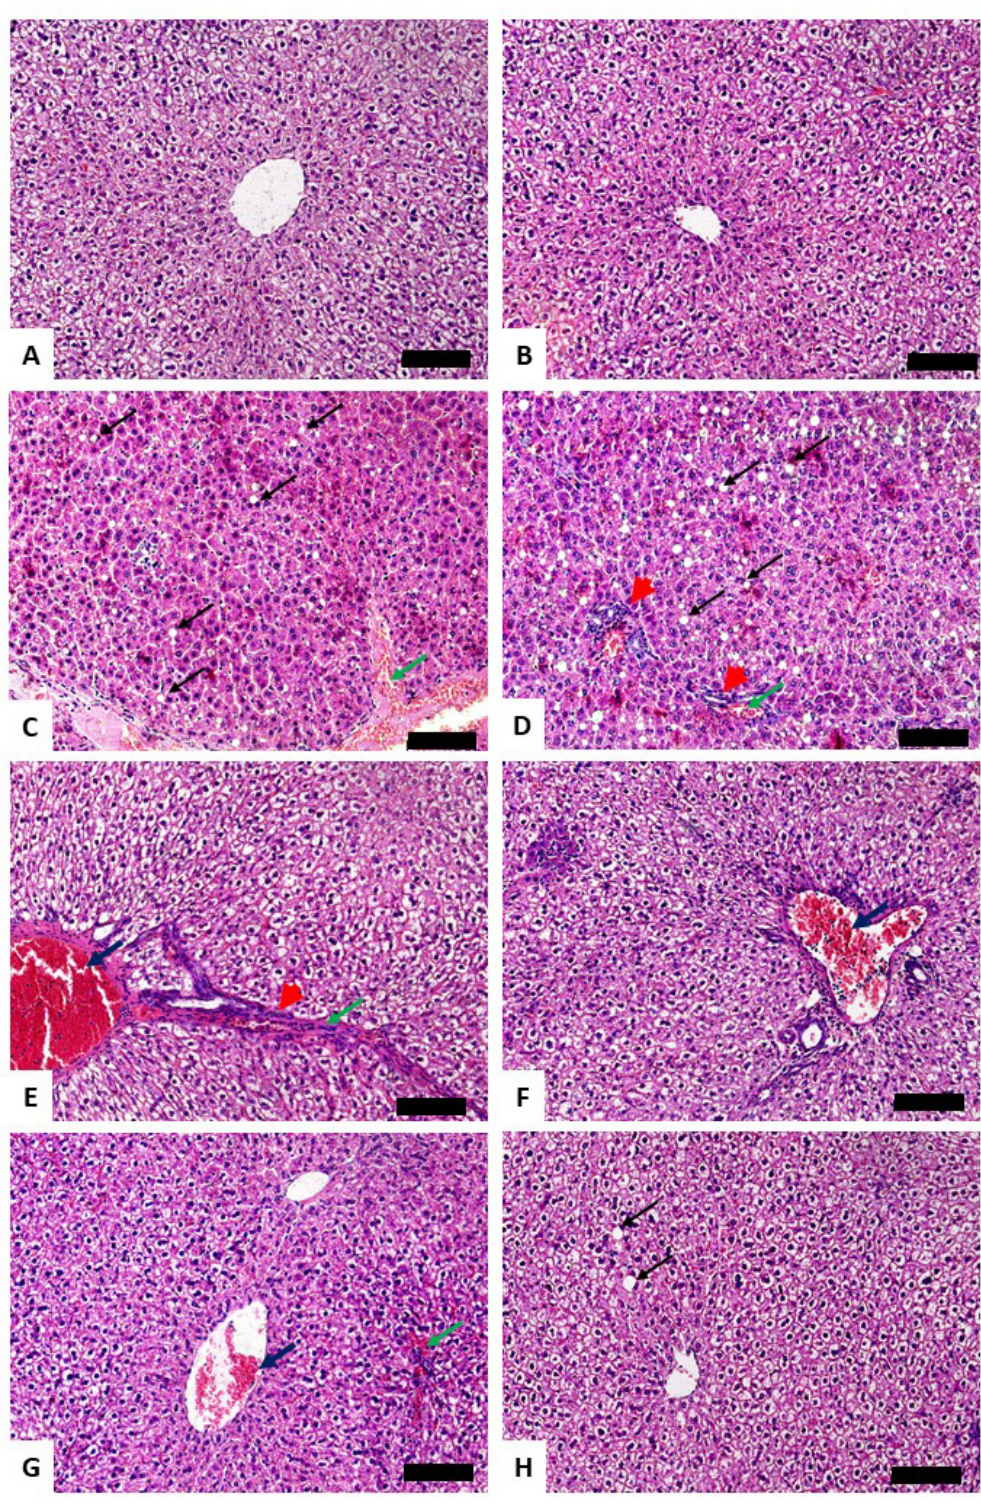
Figure 2. Photomicrographs of liver sections of ( A ) control and ( B ) Gal-treated rats showing normal liver architecture, ( C - E ) CP-intoxicated rats showing degenerative changes and cytoplasmic vacuolations (black arrow), leukocyte infiltration (arrowhead), hemorrhage (green arrow), and congestions (blue arrow), and CP-induced rats pre-treated with ( F ) 15 mg/kg, ( G ) 30 mg/kg, and ( H ) 60 mg/kg Gal showing mild congestion (blue arrow), hemorrhage (green arrow), and cytoplasmic vacuolations (black arrow). (Hematoxylin and eosin (H&E); X200) (Scale bar = 100 μm).